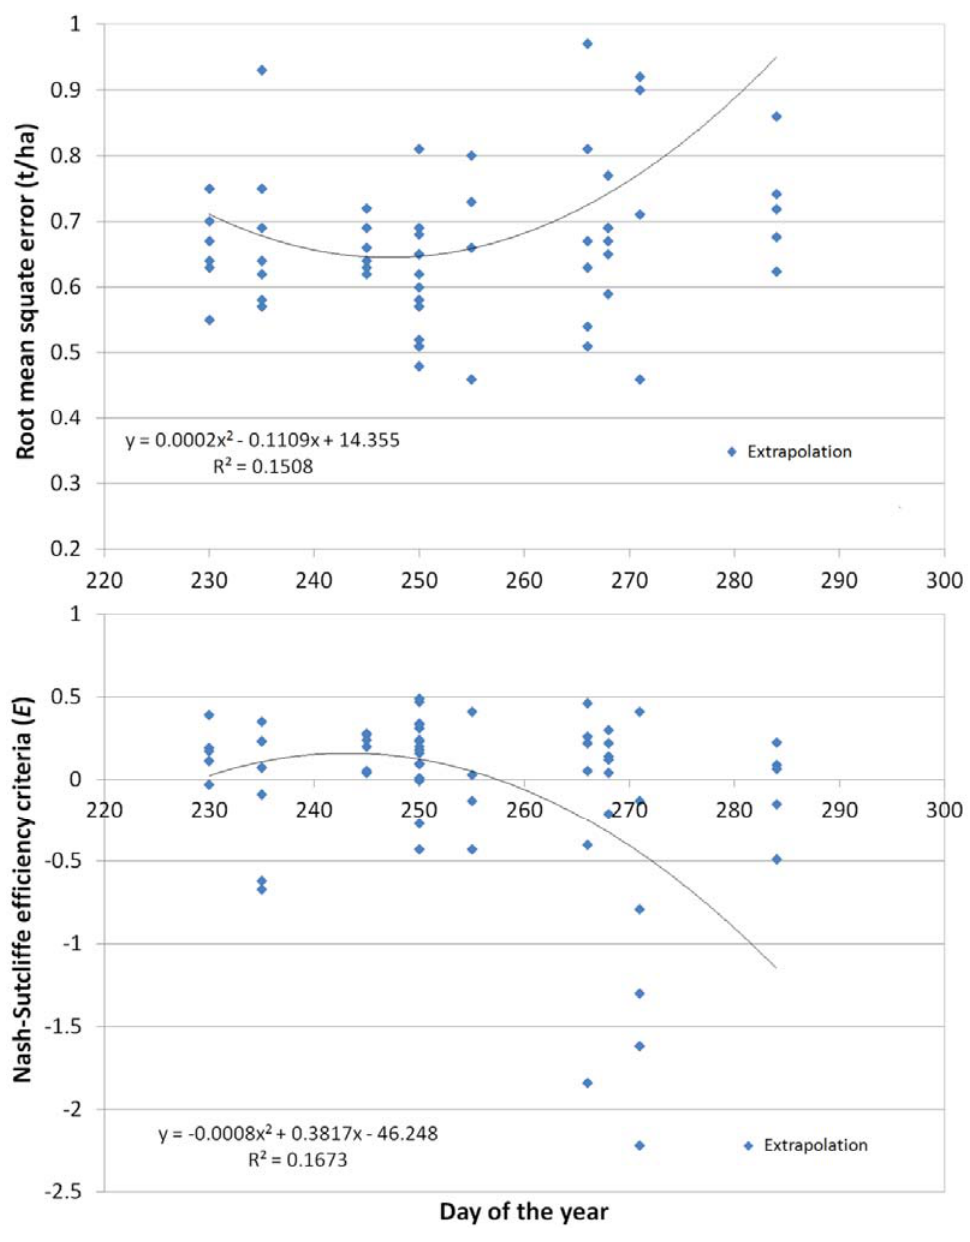
Figure 4. Root Mean Square Error (RMSE) and the Nash-Sutcliffe Efficiency Criteria ( E ) values by day of the year for the extrapolation of the regression